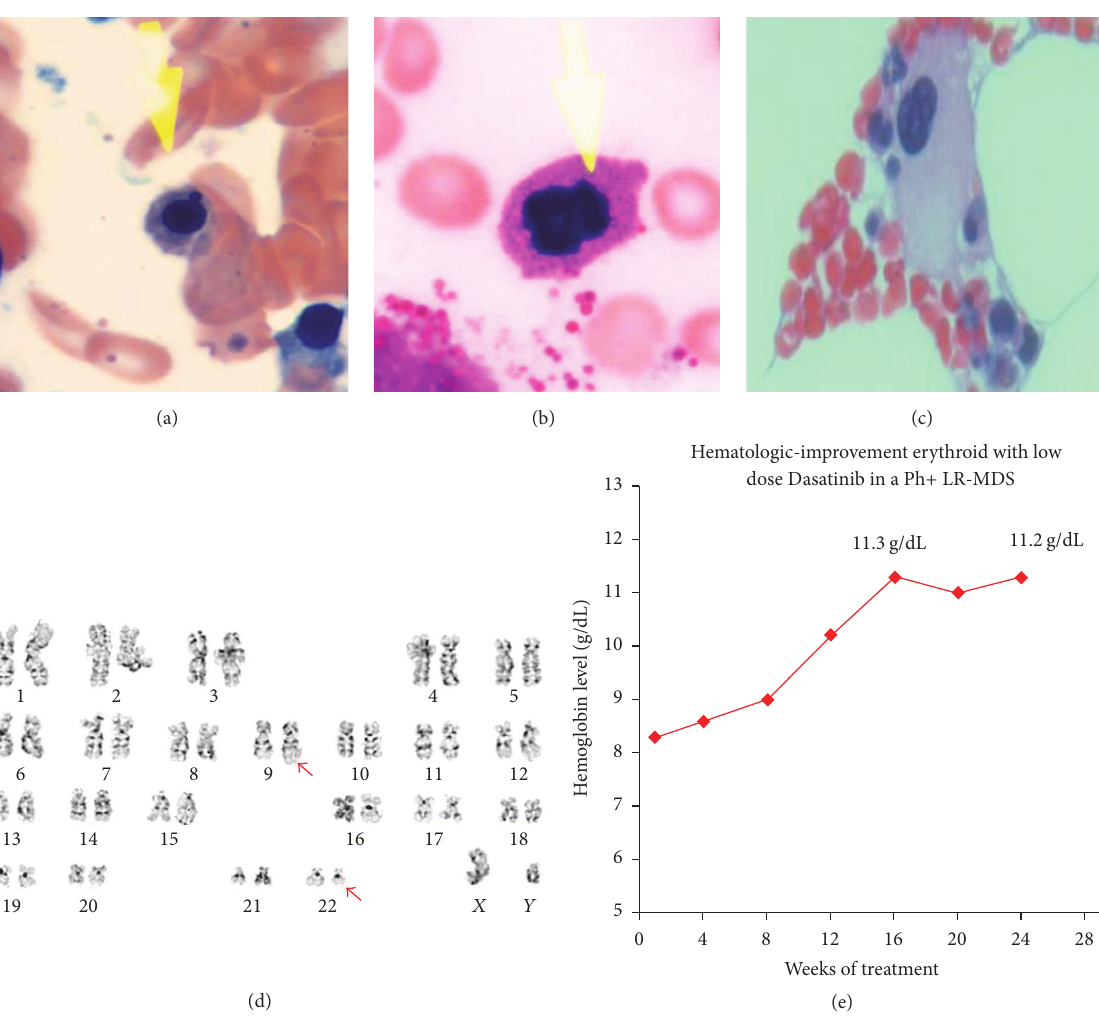
Figure1:Bonemarrowaspirate,biopsy,metaphasescytogenetic,andresponsetoDasatinibinaPh+LR-MDSpatient. (a)Erythroidprecursor with nuclear irregularity, budding, and nuclear/cytoplasm desynchronization. (b) Dysplastic erythroid precursors with karyorrhexis. (c) shows hypolobated dysplastic megakaryocytes. (d) Patient karyotype showing t (9; 22) translocation. (e) Progressive increase in hemoglobin level for a Ph + LR-MDS [RCMD] patient treated with low-dose Dasatinib. Progressive H-E was observed at 12 weeks. HI-E was sustained at 24 weeks of